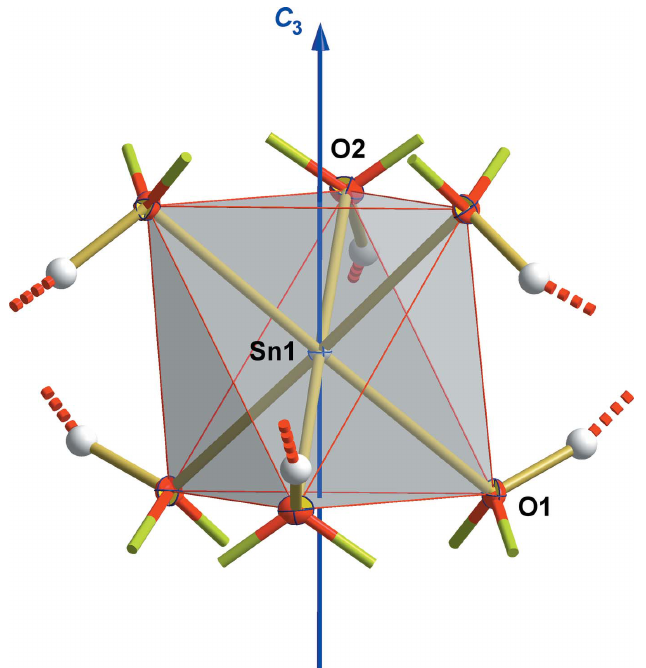
Figure 1 Ball-and-stick model of the [Sn(OH) 6 ] 2 (cid:3) ion with atom numbering of the asymmetric unit and orientation of the threefold rotation axis (blue). With exception of the hydrogen atoms, which are shown as spheres of arbitrary radius, all other atoms are drawn as displacement ellipsoids at the 40% level. Bonds between oxygen and barium are indicated as shortened, two-colored sticks while hydrogen bonds are visualized as dashed lines (red).